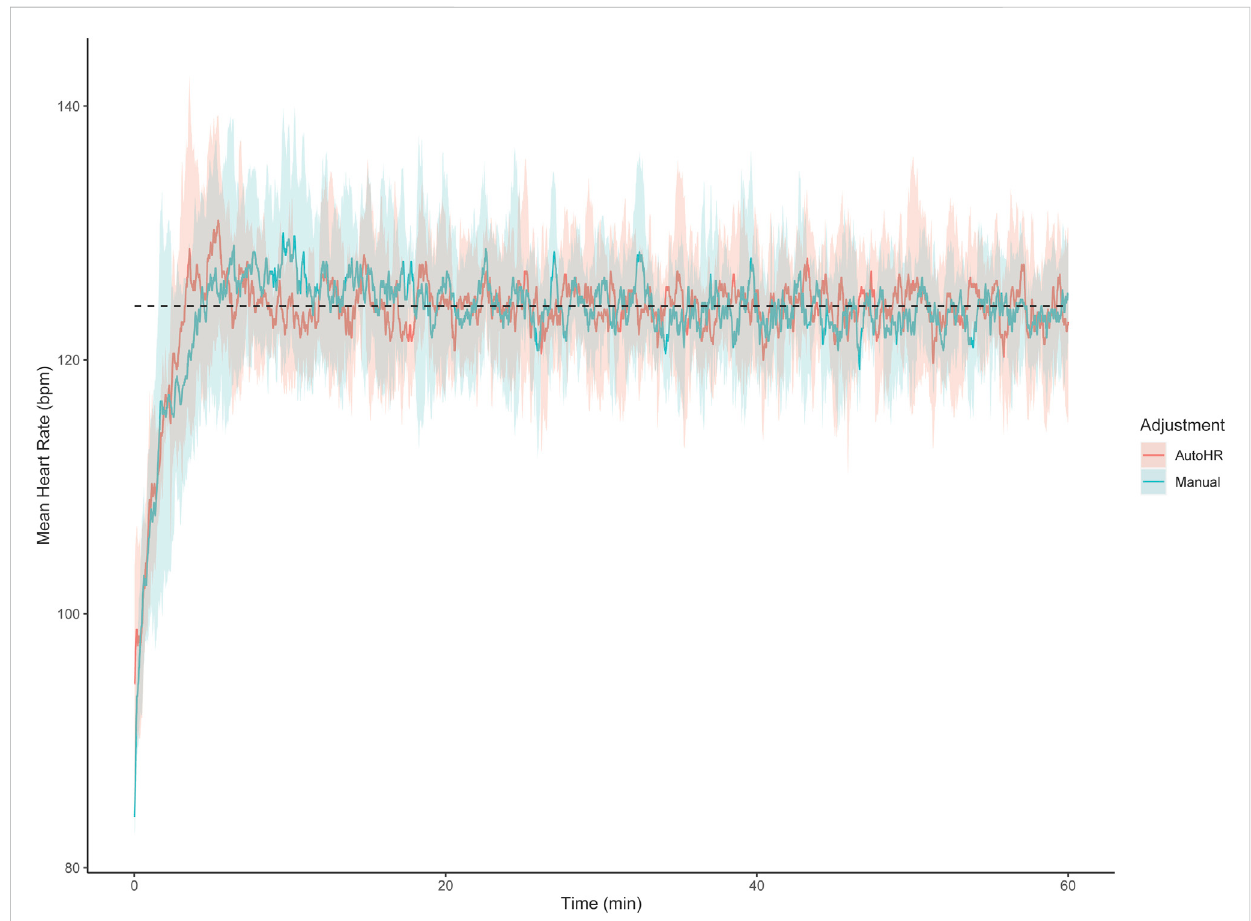
FIGURE 1 Pilot data depicting average heart rate across 60 min of heart rate clamped cycling between automatic (AutoHR) and manual control of power output. Dashed line represents average target heart rate (124 bpm). The shaded areas represent the standard deviation of mean actual heart rate.